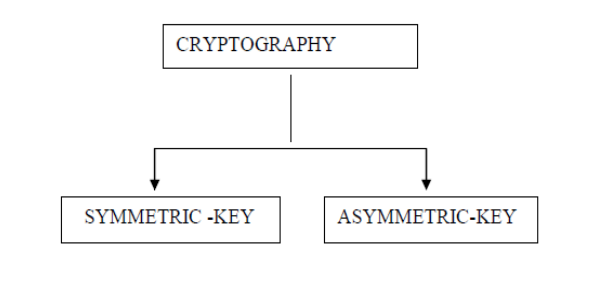
Fig. 1. Concept of